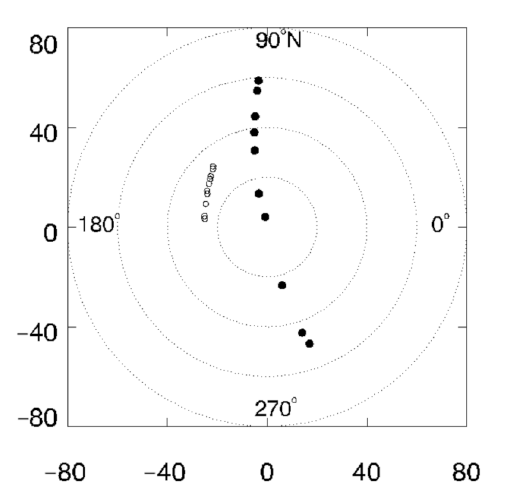
Figure 2. Angular samplings of MODIS observations for a pixel during 162 − 177, 2010 in h20v11. The open and solid circles represent the sun and viewing locations. The radius represents the zenith angle with a 20° increment and the polar angle represents the azimuth angle.